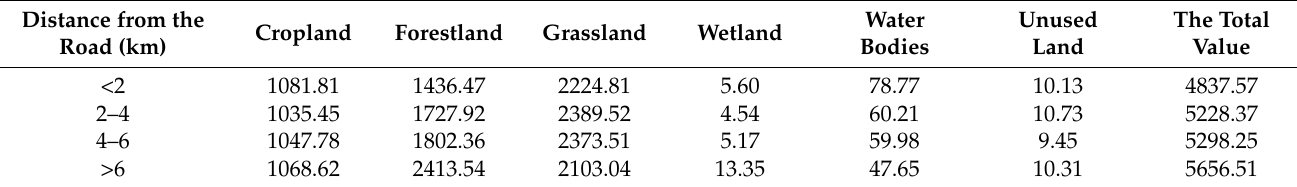
Table 11. ESV per unit area at different distances from roads. Unit: CNY/hm 2 .